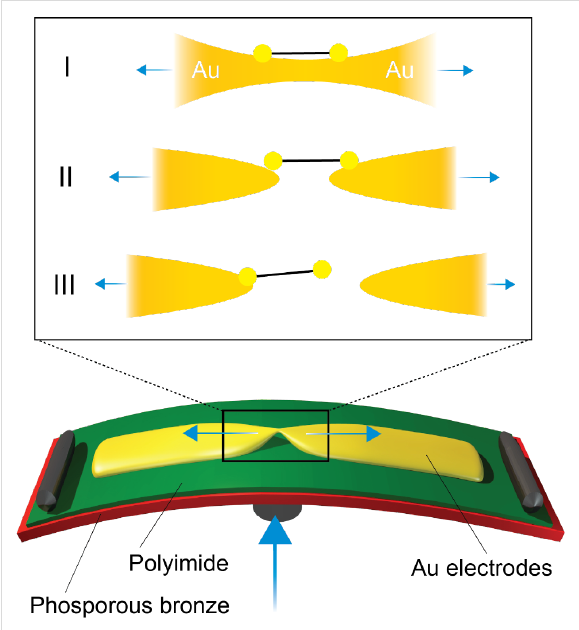
Figure 2: Drawing of the MCBJ setup and schematics of the formation of a molecular junction.